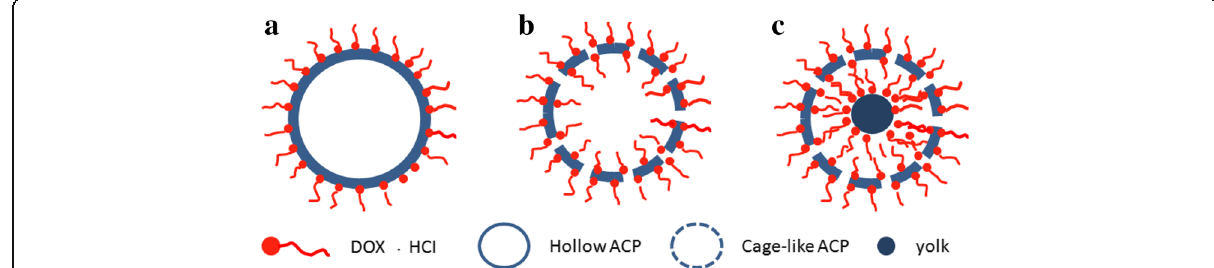
Fig. 6 The adsorption behaviors of DOX · HCl on the ACP particles with different morphologies. a hollow spheres without big pores on shell b cage-shell hollw spheres c yolk @ cage-shell hollow